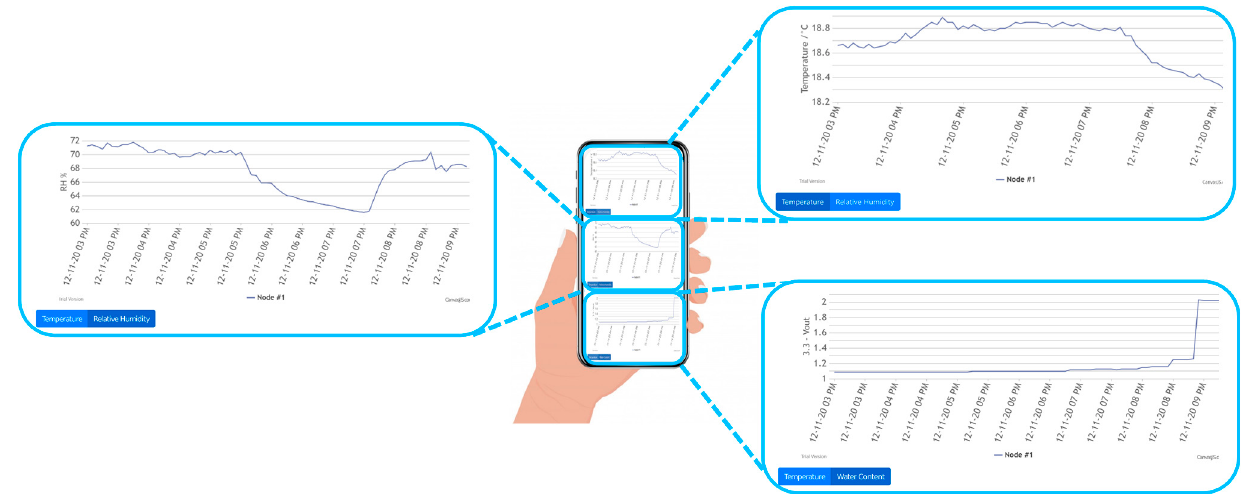
Figure 9. Simultaneous acquisition of ambient temperature and ambient relative humidity (RH) of the greenhouse node and soil water content of a single plant node, shown on the display of a portable device.